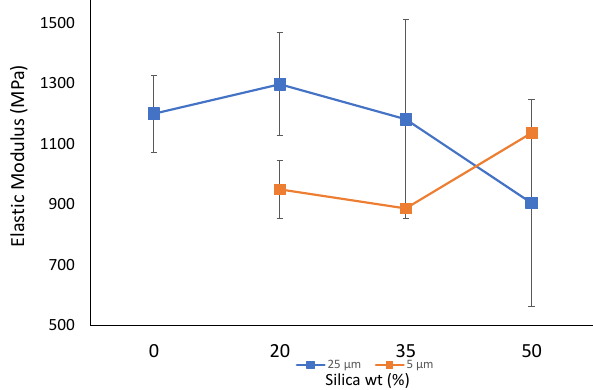
Figure 4. Elastic modulus of the prepared composite sheets.